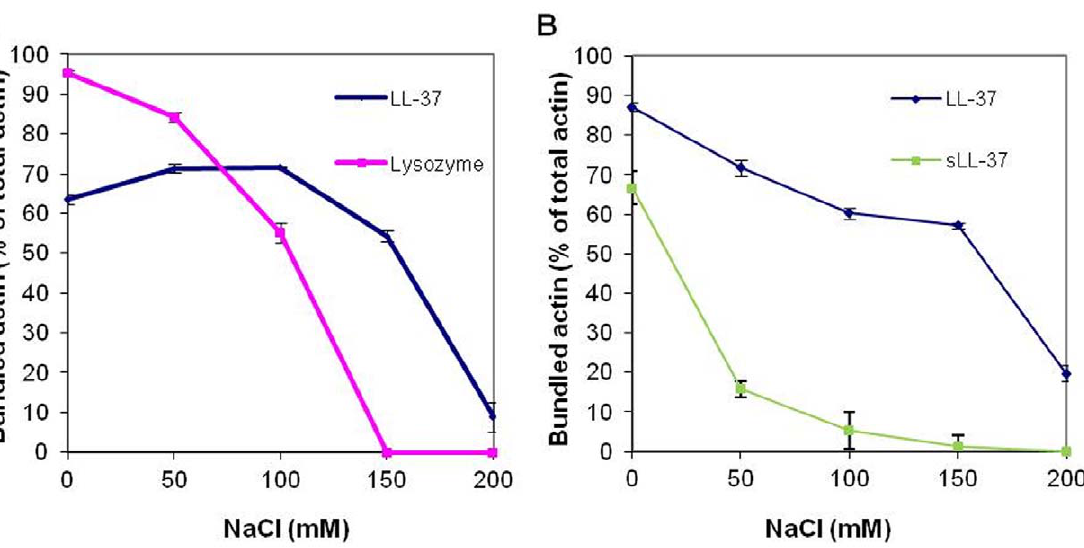
Figure 4. NaCl concentration dependent bundling of MgF-actin by LL-37, lysozyme and sLL-37. ( A ) 6 m M lysozyme or LL-37 were added to Mg-F-actin (4 m M). ( B ) 10 m M LL-37 or sLL-37 were added to 4 m M MgF-actin After 10 min incubation at room temperature samples were centrifuged at 20,800 6 g for 8 min. The supernatants were analyzed by SDS-PAGE and densitometry. The presented data are mean and standard deviation of three independent experiments.